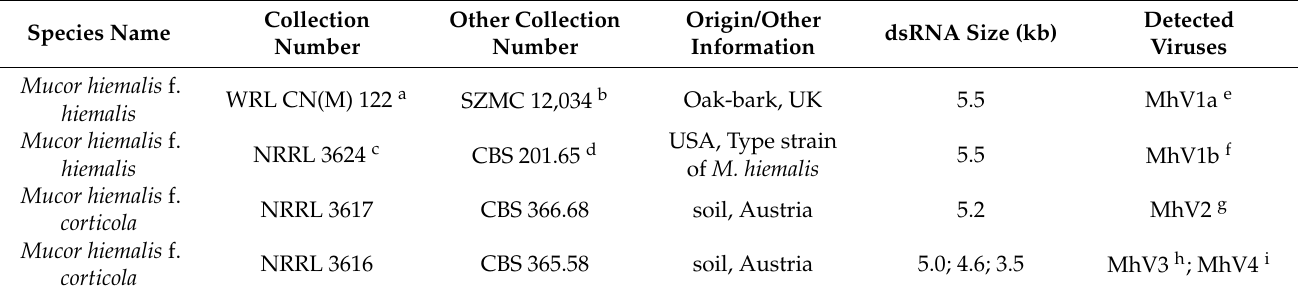
Table 1. Sizes of dsRNA molecules detected in Mucor